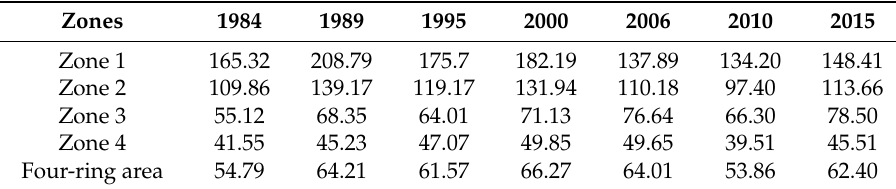
Table 3. Runoff depth in different regions from 1984 to 2015 (mm).